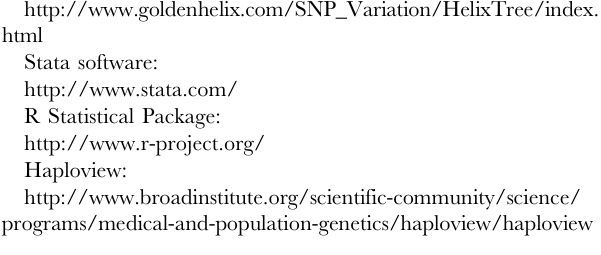
Figure S1 Manhattan plot and QQ plot showing the -log10 of the Mantel-Haenszel P value of all 279,621 SNPs in the lcSSc individuals of the GWAS cohorts comprising 1,400 cases and 5,171 controls. All P values are GC corrected, and l was 1.058. (TIF) Figure S2 Manhattan plot and QQ plot showing the -log10 of the Mantel-Haenszel P value of all 279,621 SNPs in the dcSSc individuals of the GWAS cohorts comprising 740 cases and 5,171 controls. All P values are GC corrected, and l was 1.034. (TIF) Figure S3 Manhattan plot and QQ plot showing the -log10 of the Mantel-Haenszel P value of all 279,621 SNPs in the ACA positive individuals of the GWAS cohorts comprising 761 cases and 5,171 controls. All P values are GC corrected, and l was 1.050. (TIF) Figure S4 Manhattan plot and QQ plot showing the -log10 of the Mantel-Haenszel P value of all 279,621 SNPs in the ATA positive individuals of the GWAS cohorts comprising 447 cases and 5,171 controls. All P values are GC corrected, and l was 1.061. (TIF) Figure S5 Manhattan plot showing the analysis in the GWAS cohorts imputed data. The different subphenotypes considered are represented in different colors. (TIF) Table S1 Analysis for GWAS cohorts, replication cohorts and combined analysis for all non-HLA, non-previously described associations with lcSSc subtype of the disease. { P values for GWAS cohorts are Mantel-Haenszel meta-analysis GC corrected accord- ing to the set l and in the replication and combined analysis Mantel-Haenszel meta-analysis P value. { P value for the totality of the SSc patients, in the case of GWAS cohorts GC corrected according to the set l , and in replication and combined analysis Mantel-Haenszel meta-analysis P value. (DOC) Table S2 Analysis for GWAS cohorts, replication cohorts and combined analysis for all non-HLA, non-previously described associations with dcSSc subtype of the disease. { P values for GWAS cohorts are Mantel-Haenszel meta-analysis GC corrected according to the set l and in the replication and combined analysis Mantel-Haenszel meta-analysis P value. { P value for the totality of the SSc patients, in the case of GWAS cohorts GC corrected according to the set l , and in replication and combined analysis Mantel-Haenszel meta-analysis P value. *Association in rs11171747 had a significant BD P value, thus making them heterogenic associations among populations. (DOC) Table S3 Analysis for GWAS cohorts, replication cohorts and combined analysis for all non-HLA, non-previously